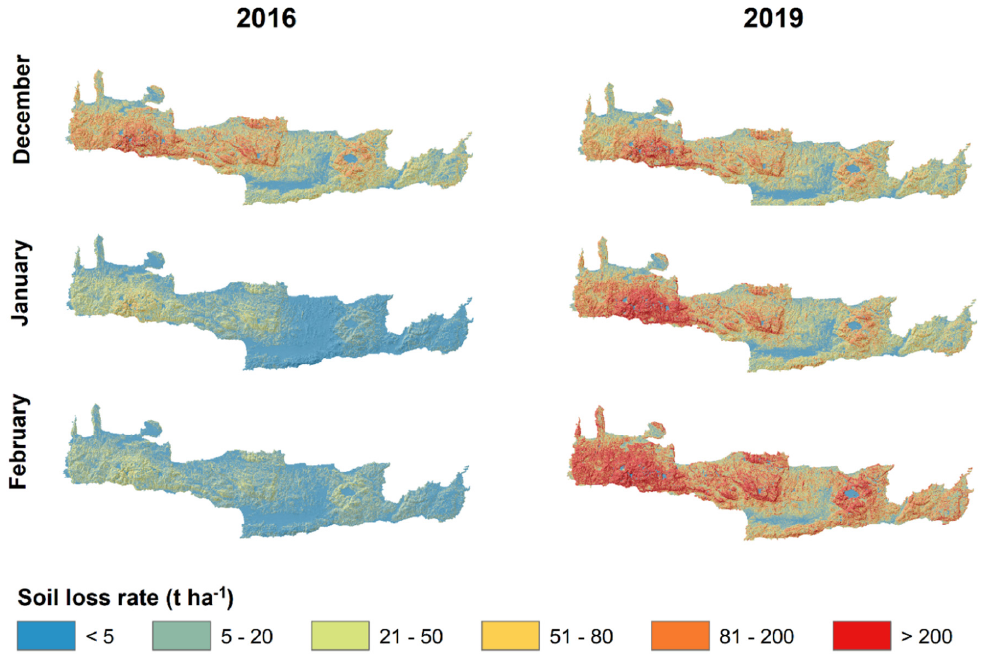
Figure 3. Monthly spatial distribution of soil loss rate for Crete Island in 2016 and 2019.